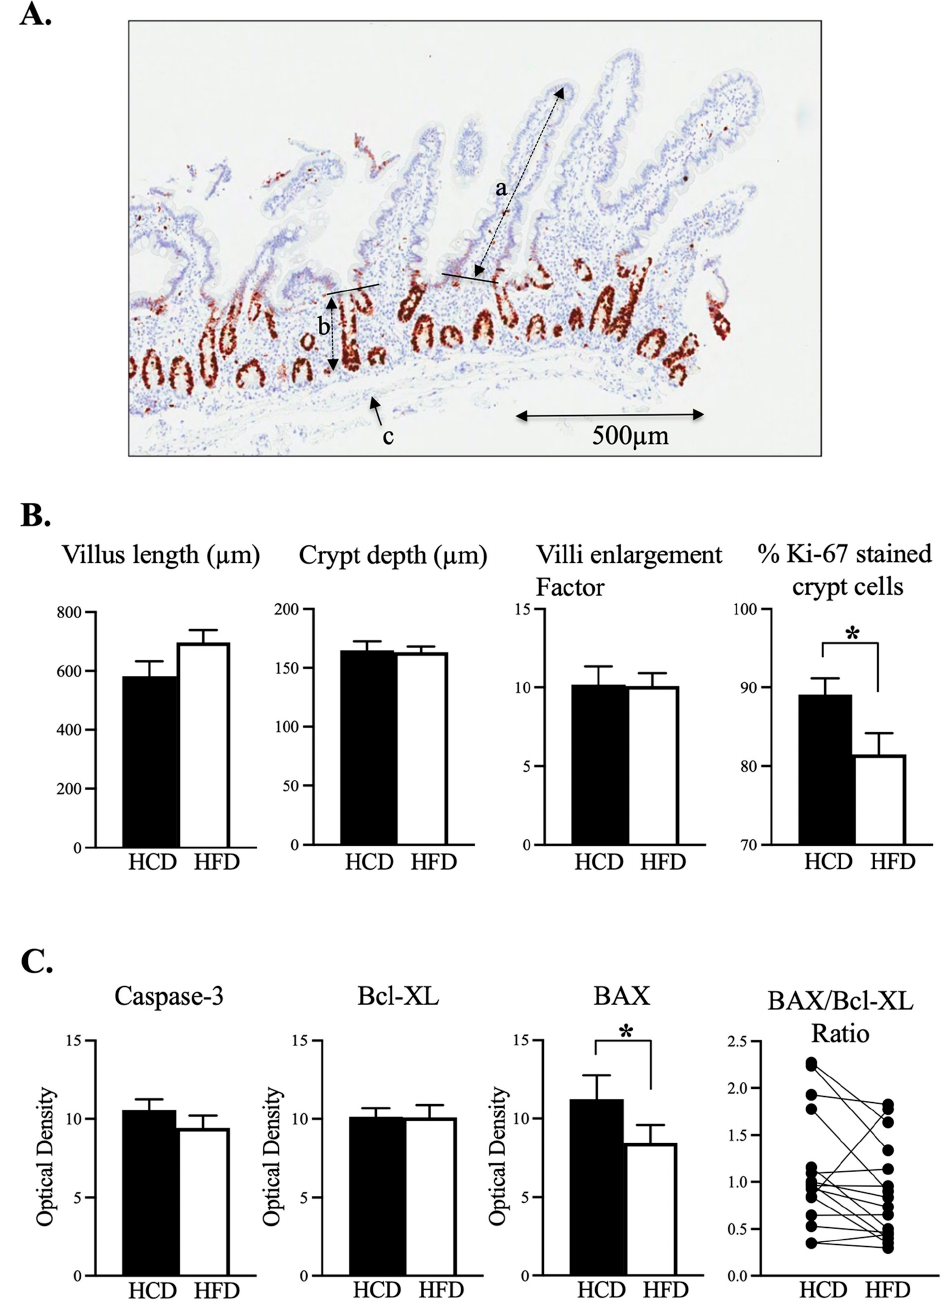
Figure 1. ( A ). The upper panel shows one example of a sectioned biopsy with a haematoxylin background and Ki-67 stained (brown). Villus length (a) and crypt depth (b) were assessed only where tissue orientation was optimal and allowed identification of tip of villus, transition from villus to crypt and the crypt bottom. Villi enlargement factor was assessed using the gridline intersection method of the surface epithelium in relation to muscularis mucosae (the latter depicted in c). ( B ). Villus length, crypt depth and villi enlargement factor were on a similar magnitude following HCD or HFD. Ki-67 cells in the crypts were significantly more stained in relation to all cells after HCD compared to after HFD ( p = 0.027). ( C ). The lower panel shows the apoptosis biomarkers Caspase-3 and Bcl-XL, which did not differ between diets. BAX was increased following HCD as compared to HFD ( p = 0.034). However, the ratios of BAX/Bcl-XL were on a similar level independent of diet. Data are means + SEM; n = 11–15; * p ≤ 0.05 Wilcoxon signed-rank